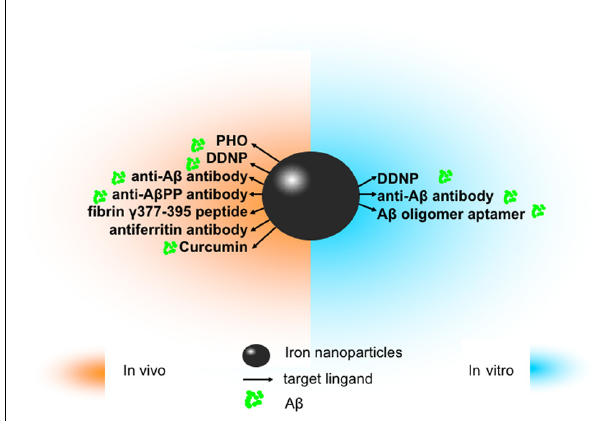
FIGURE 1 | The application of iron oxide nanoparticles (IONPs) in diagnosis and treatment of Alzheimer’s disease (AD). Since amyloid β (A β ) has been identified as an ideal imaging biomarker of AD at present, with the help of magnetic resonance imaging (MRI), IONPs can be used for the detection of A β to assist in diagnosis and treatment of AD. In vitro , magnetic nanoparticles (MNPs) labeled with antibodies against A β -40 and A β -42 is applicable to detect A β in the blood. Conjugated with the A β oligomer aptamer and the complementary oligonucleotide of the A β oligomer aptamer, IONPs can be developed as a method to measure the A β oligomer in the artificial cerebrospinal fluid (CSF). DDNP-superparamagnetic iron oxide nanoparticles (SPIONs) with high affinities to A β ( 1–40 ) aggregates can be detected by fluorophotometry. In vivo , ultrasmall superparamagnetic iron